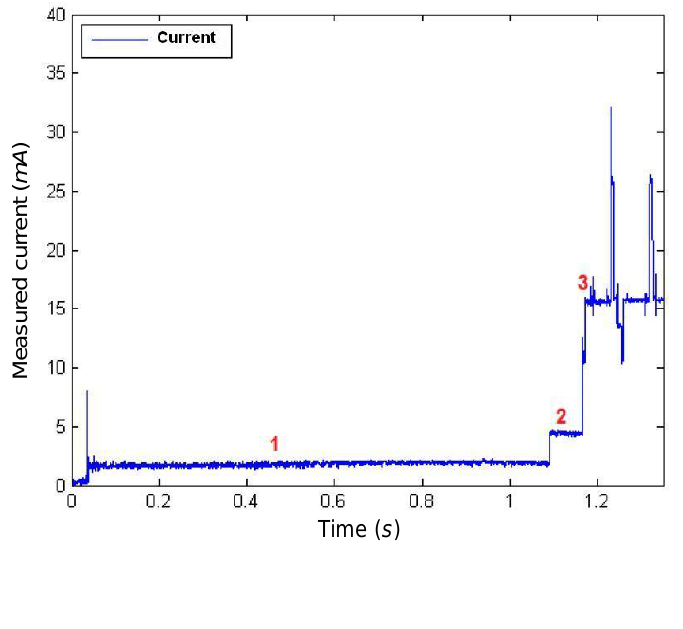
Figure 2. Measured supply current during the start-up of the